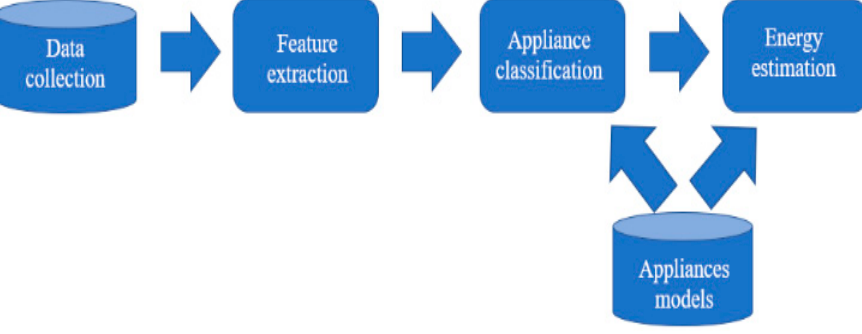
Figure 1. NILM overview.